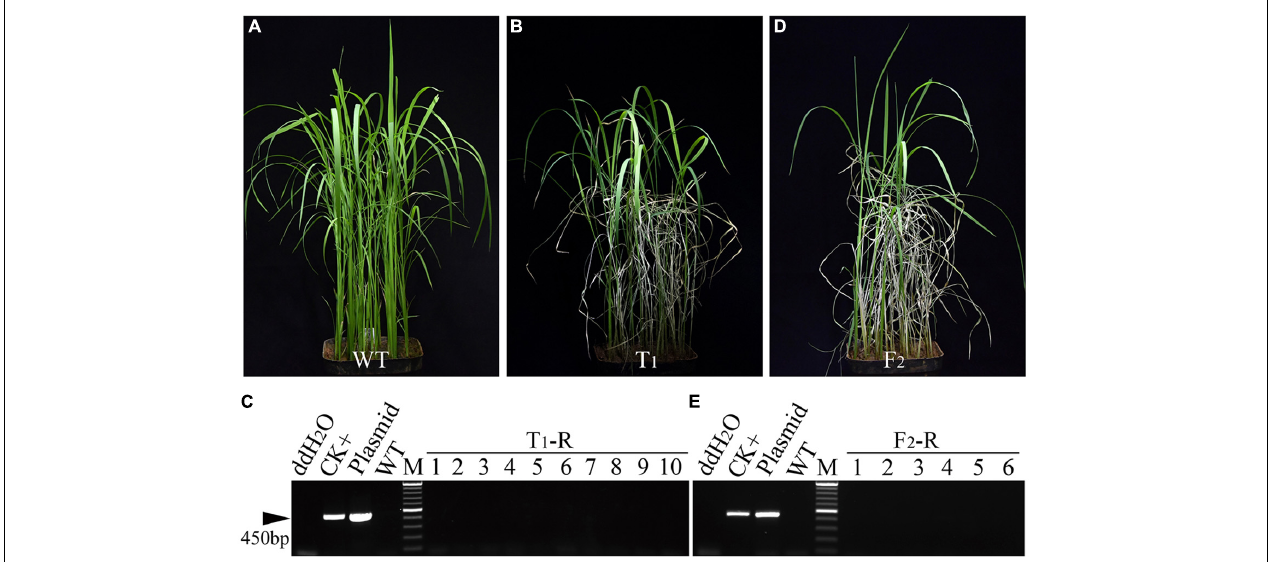
FIGURE 2 | Screening of transgene-free plants from segregation progeny of independent transgenic T 0 lines carrying the AT72 T-DNA fragment. (A,B) Symptoms of wild-type (WT) Ilmibyeo (A) , transgenic T 1 progeny (#1) (B) . (C) PCR screening using Hyg R -specific primers for BTZ R plants (T 1 -R) from transgenic T 1 progeny (#1). (D) Symptoms of F 2 populations (#7) seedlings 7 days after a BTZ foliar spray. (E) PCR screening using Hyg R -specific primers for BTZ R plants (F 2 -R) from F 2 populations (#7). CK+: transgenic positive plant; plasmid: HPE203 plasmid DNA with Hyg R ; M: Thermo Scientific GeneRuler DNA Ladder Mix (SM0333). Hyg R , hygromycin resistance